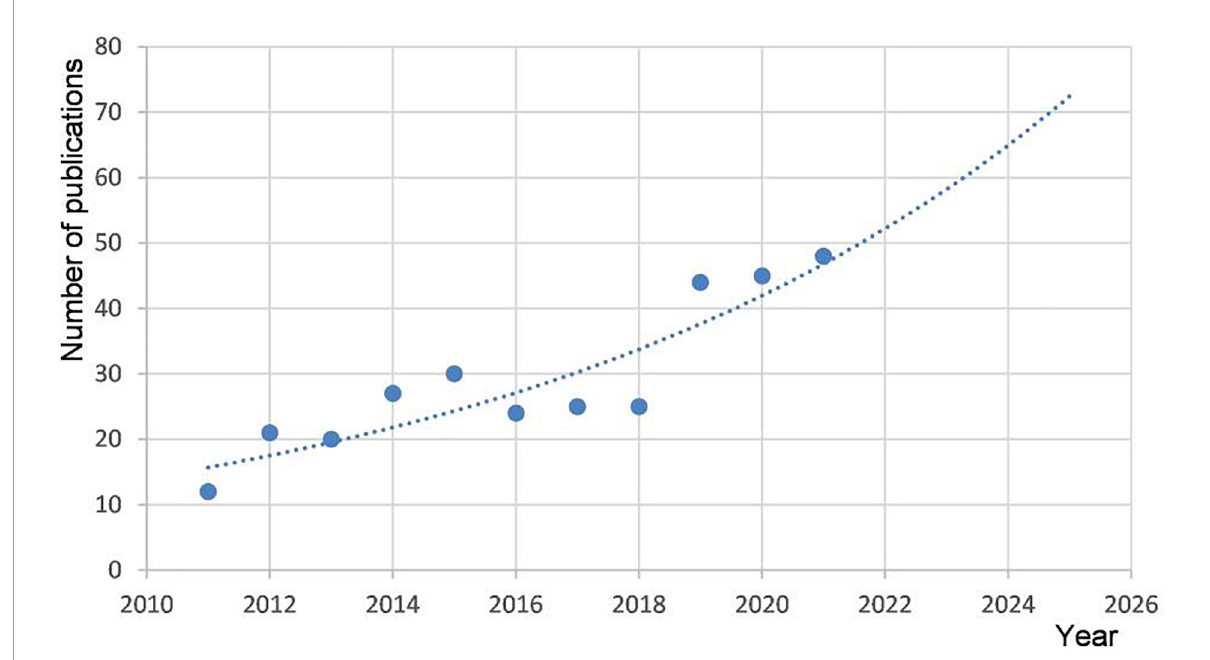
FIGURE1 Annual publications from 2011 to 2021 and the time trend of acupuncture on cardiopathy.